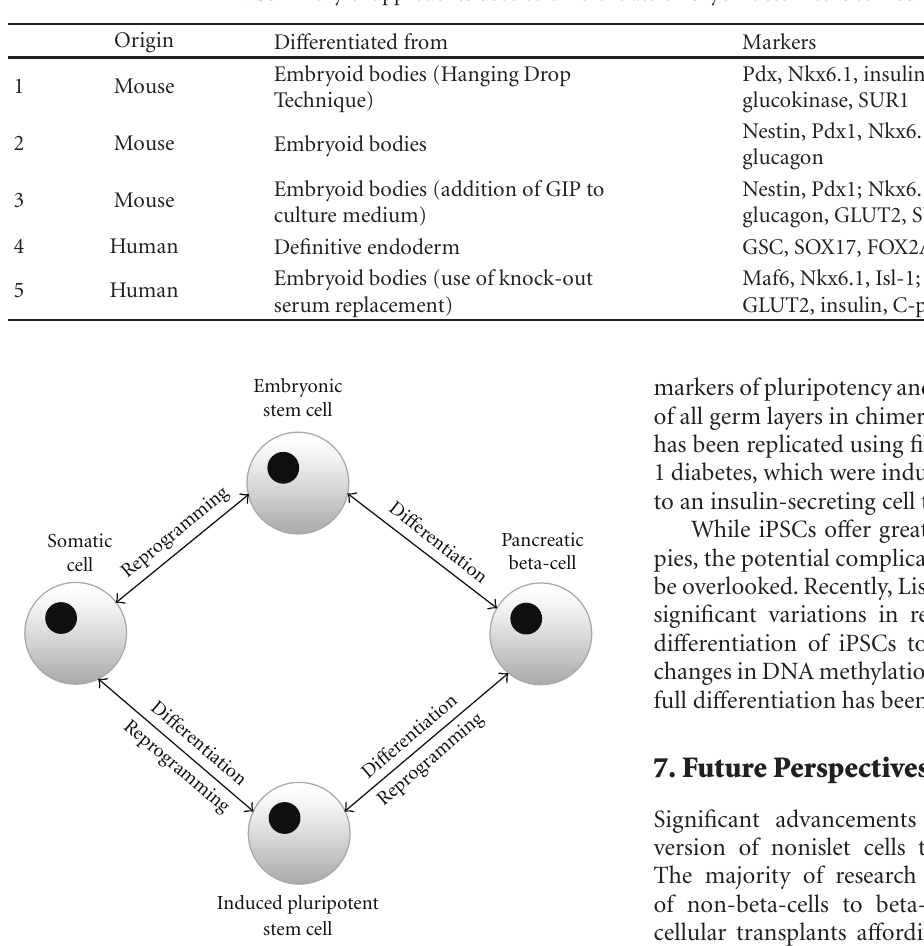
Figure 2: Directed di ff erentiation of embryonic stem cells (ESCs) and induced pluripotent stem cells (iPSCs) towards a beta-cell phenotype. ESCs are derived from the inner cell mass of the blastocyst and have the potential to develop into any somatic cell lineage. Studies have shown that ESCs can be di ff erentiated towards a beta-cell phenotype which releases insulin in response to stimuli including glucose. iPS cells are derived as a result of the directed reprogramming of somatic cells into a pluripotent phenotype. This generally involves the forced expression of a gene or transcription factor. iPSCs can be used to generate beta-like cells, while beta-cells themselves can be used to produce iPSCs for further expansion of the beta-cell